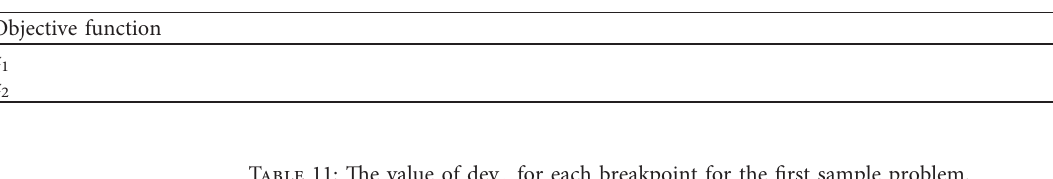
Table 10: Reference point values.